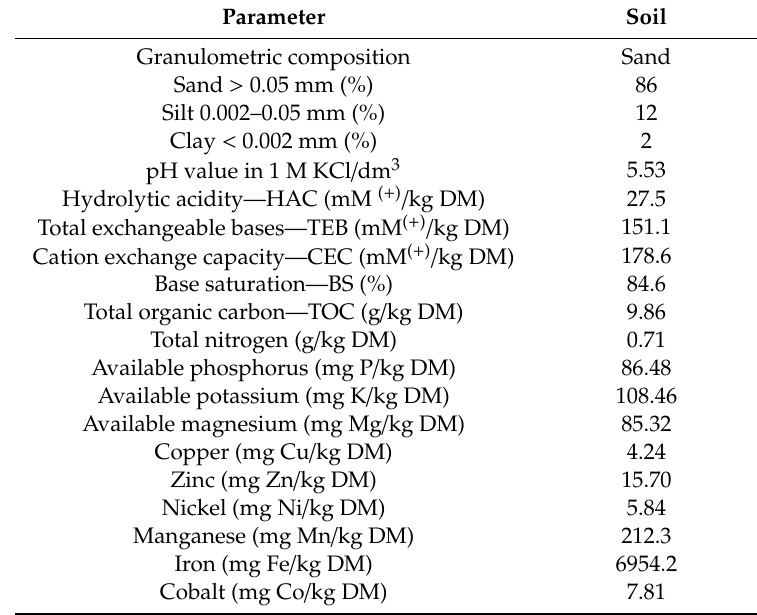
Table 1. Properties of the soil.